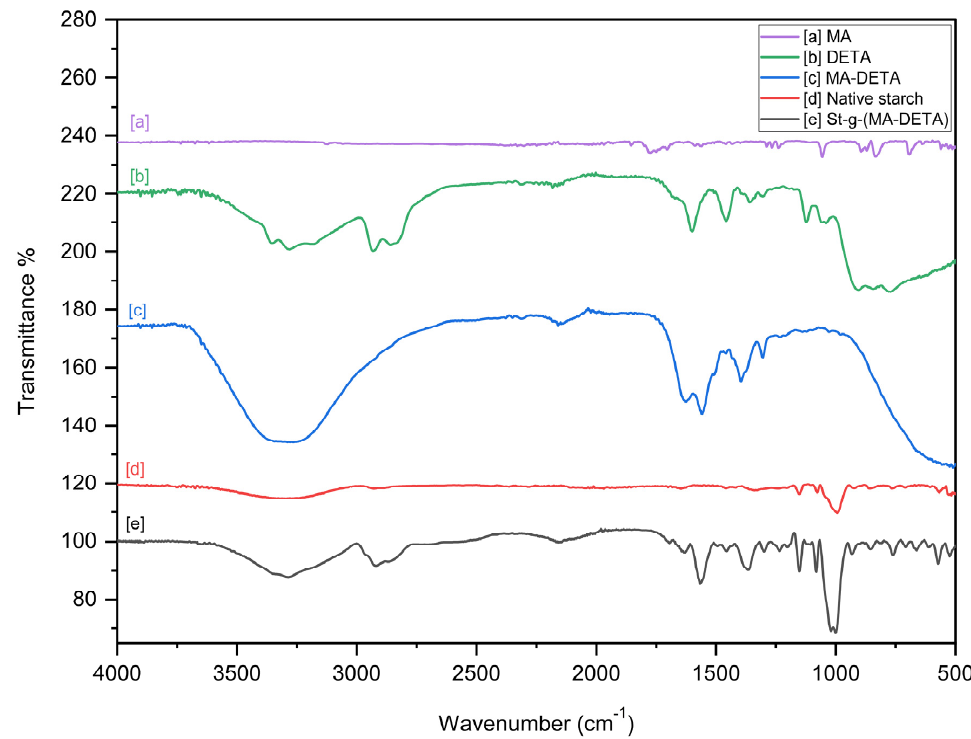
Figure 5. FT − IR of MA ( a ), DETA ( b ), prepared monomer (MA − DETA) ( c ), native starch ( d ) & St-g- (MA − DETA) ( e ). ( d ) & St-g-(MA − DETA) ( e